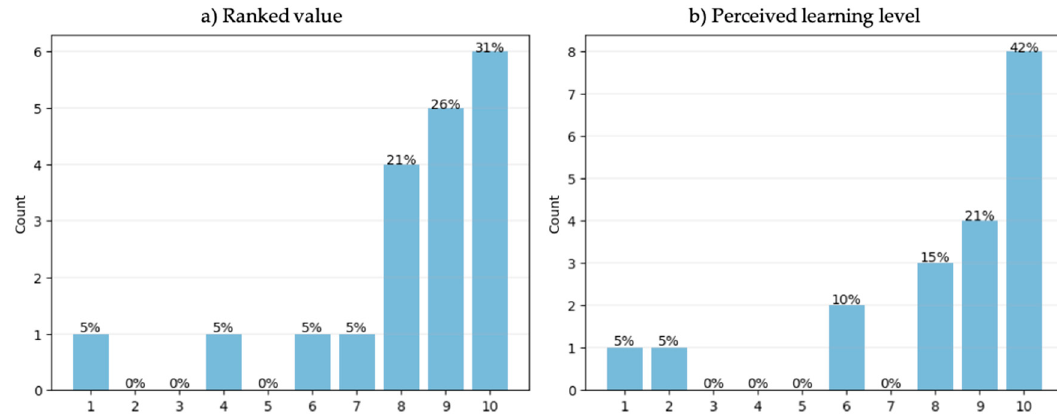
Figure 3. ( a ) Ranked value defined as votes on the question “How entertaining was the lesson?”, 1 being the minimum and 10 being the maximum value. ( b ) Perceived learning level defined as votes on the question “Do you think you’ve learned new things today?” to be valued from 1, being the minimum and 10 being the maximum number of concepts learnt.